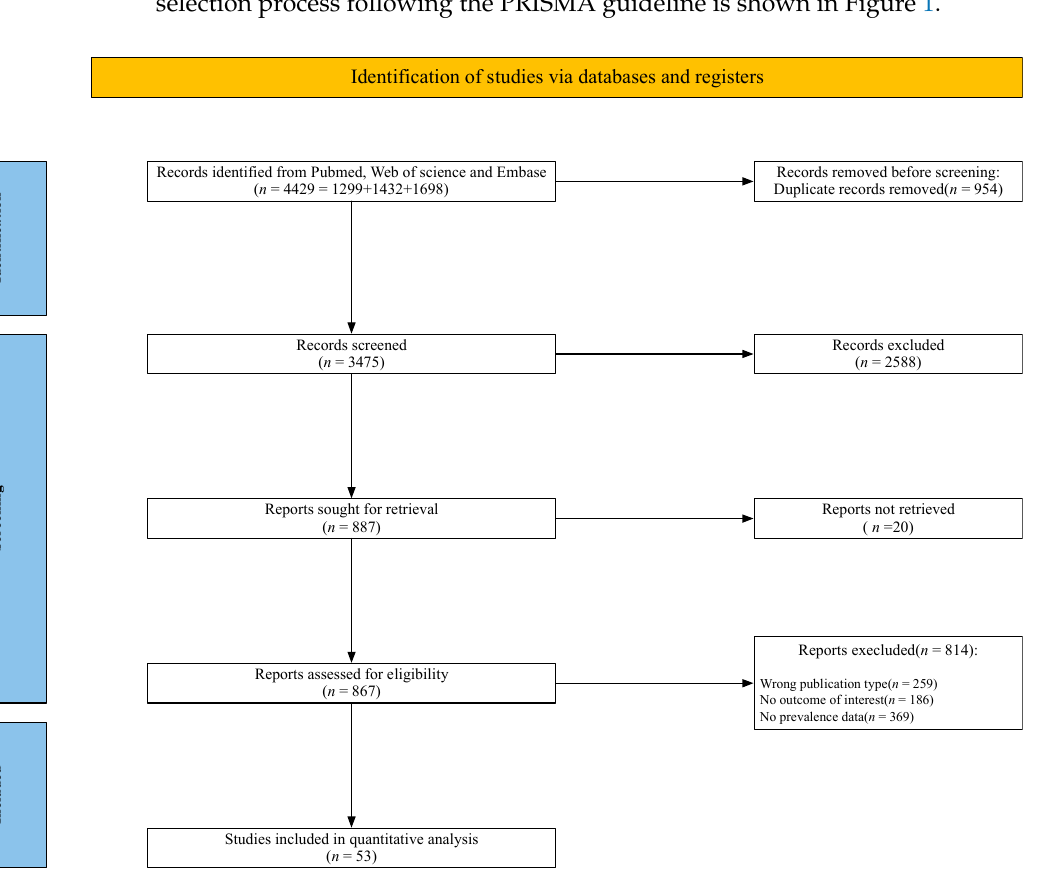
Figure 1. Flow chart of literature review and study selection.